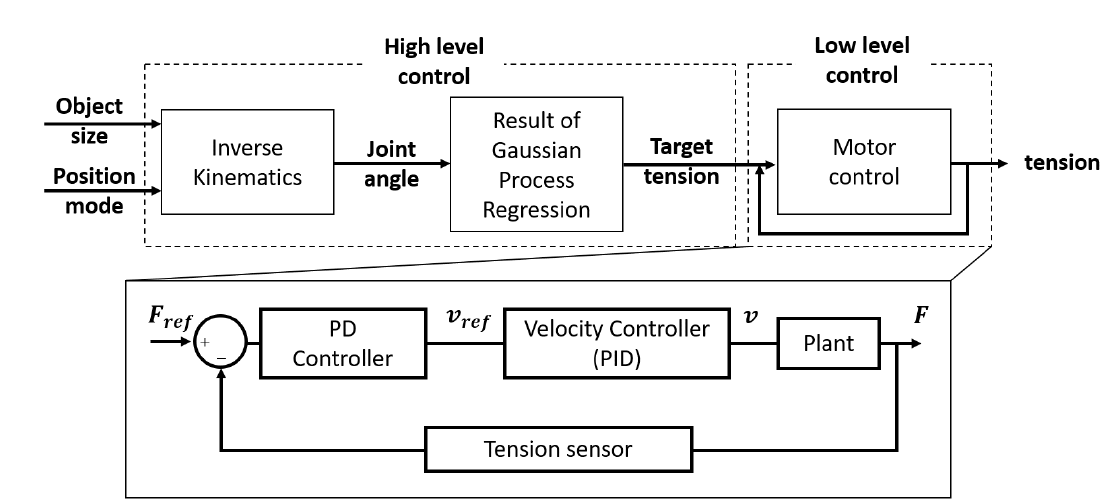
Figure 4. Block diagram of the control scheme used in the proposed